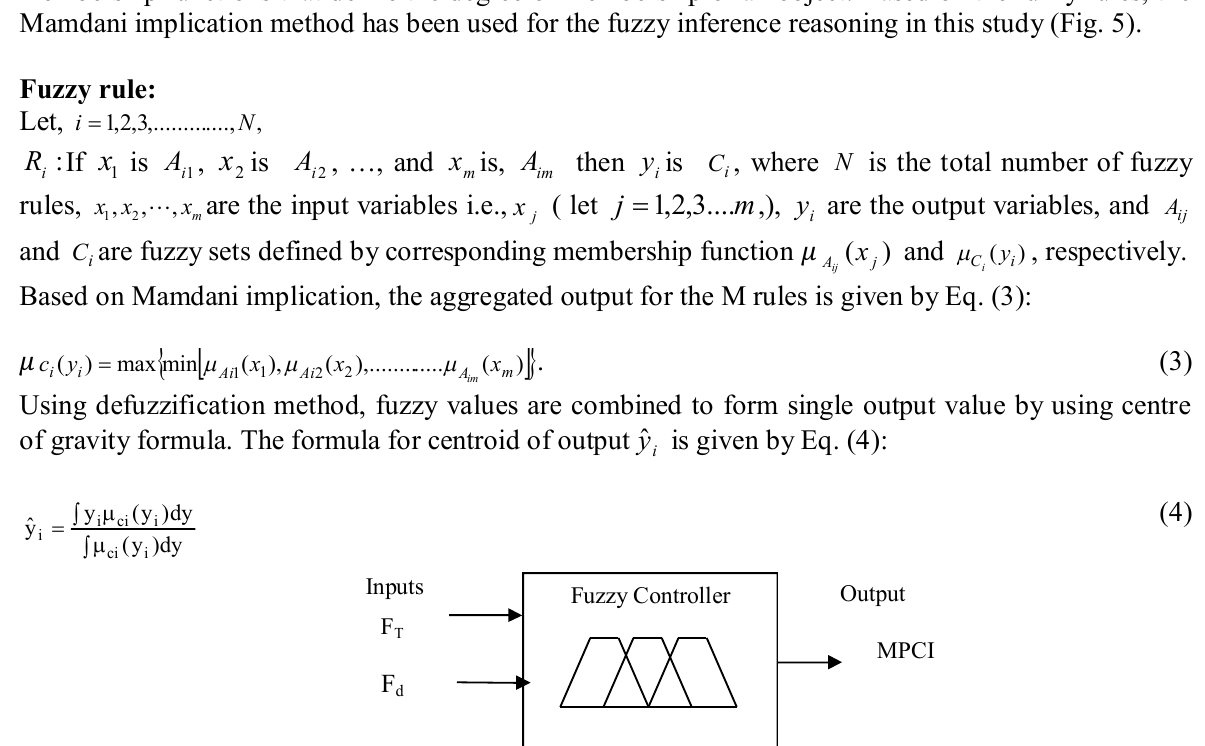
Grey relational coefficients of F